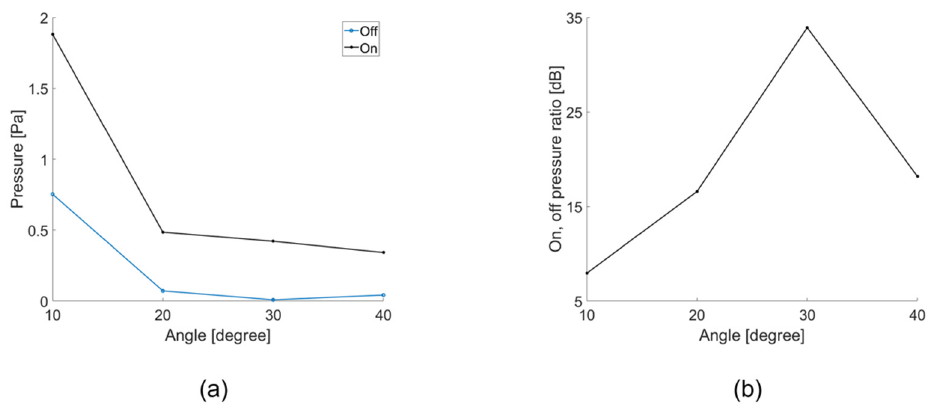
Figure 13. ( a ) Pressure measurements depending on whether the controller is operating or not (at 10° to 40°); ( b ) Reduction ratio depending on whether the controller is operating (hydrophone (RX 1) is located in the perpendicular direction of the transducer).